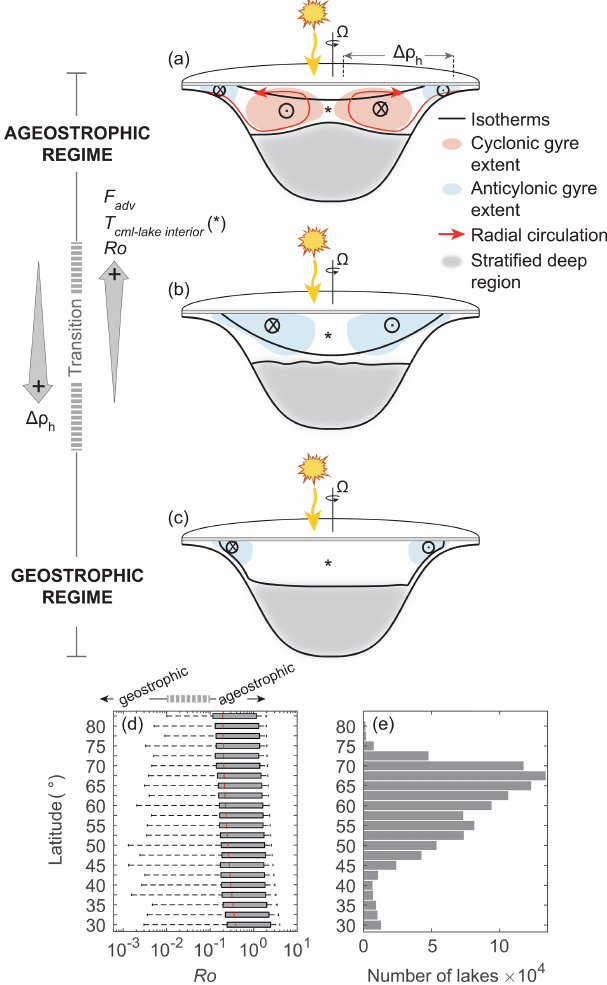
Figure 5. Conceptual model for under-ice circulation induced by differential heating. (a–c) Conceptual model for the ageostrophic and geostrophic regimes under ice. (d) Boxplot of Ro values and (e) distribution of lakes used for the calculations of Ro for latitude in- tervals of 2.5 ◦ . The HydroLAKES database (Messager et al., 2016) was used to construct panels (d–e) (see details in Sect. S1.4). Lat- itude in (d–e) is expressed in absolute values. Red lines and gray rectangles in (d) show the median value and the interquartile range,